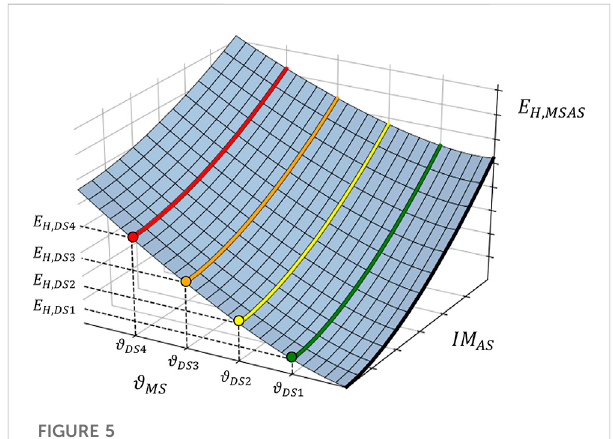
FIGURE 5 Conceptual illustration of the PSDM proposed by Gentile and Galasso